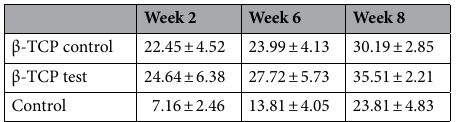
Table 4. New bone formation was observed on micro-CT scan.